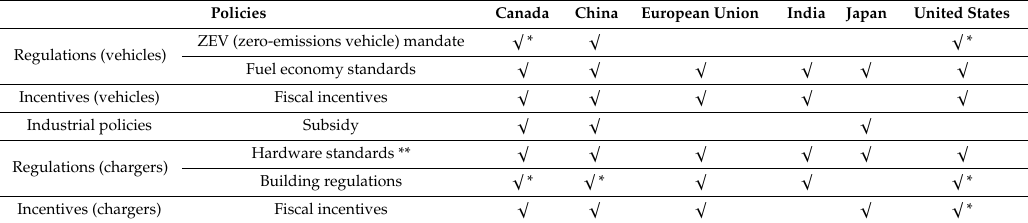
Table 1. Electric vehicle (EV)-related policies in selected